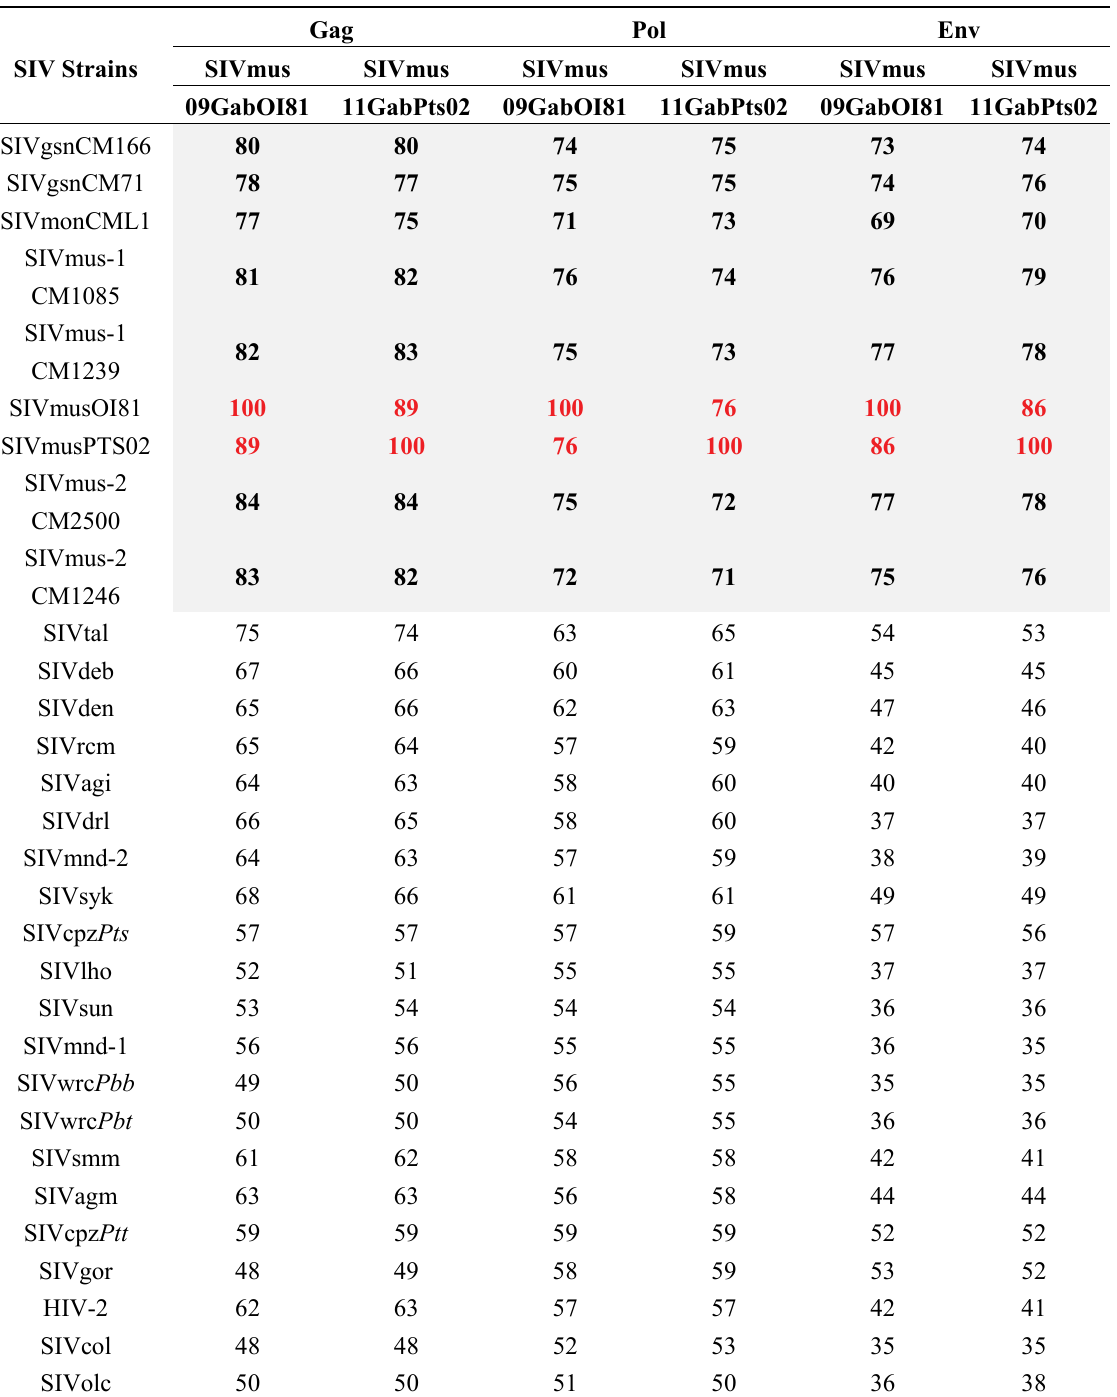
Table 1. Percent amino acid identity between new SIVmus strains (09Gab-OI81 and 11GabPts-02) and SIV strains representative to other SIV lineages in the three major genes Gag, Pol, and Env. Grey rectangles show the percentage of amino acid identity between the two new SIVmus-09Gab-OI81 and -11Gab-Pts02 strains (highlighted in red) and other SIV strains (in bold) from the SIVmus/mon/gsn lineage along the three major genes Gag, Pol, Env. SIV